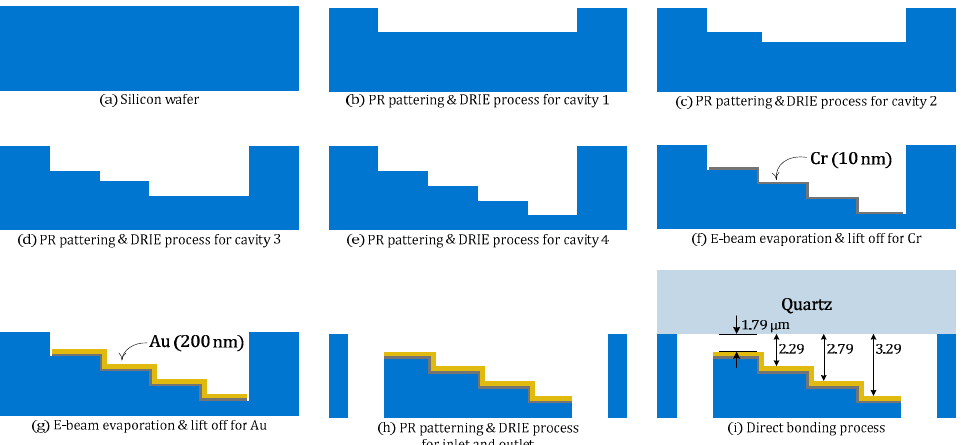
Figure 4. SPR sensor chip fabrication process with stepped air-gaps ( a ) silicon substrate; ( b ) first DRIE process; ( c ) second DRIE process; ( d ) third DRIE process; ( e ) fourth DRIE process; ( f ) Cr evaporation; ( g ) Au evaporation; ( h ) DRIE for inlet and outlet; ( i ) direct bonding process.